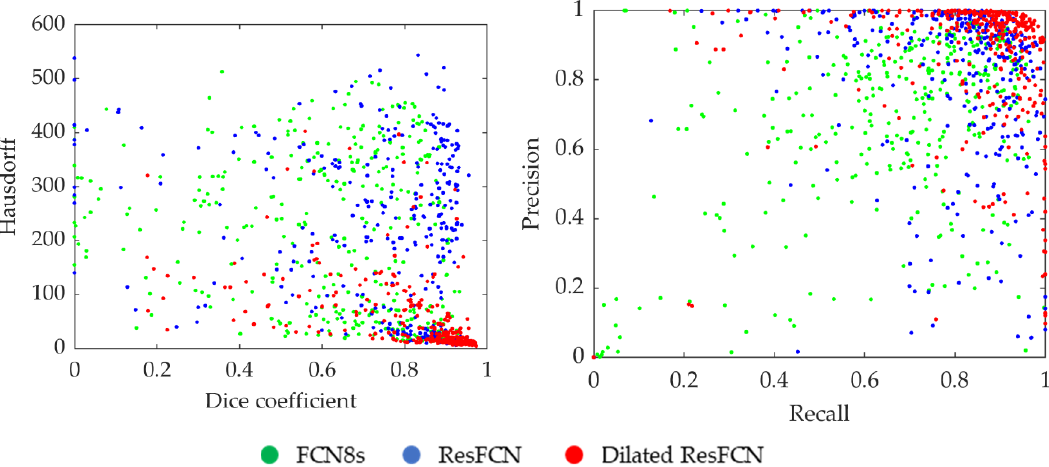
Figure 14. Distribution of the results when using different segmentation methods, where each point corresponds to one of the validation images.